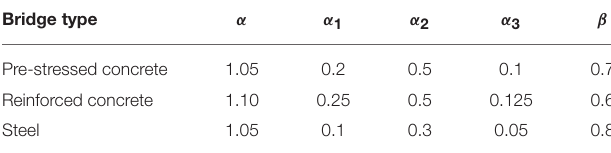
TABLE 2 | Determination of parameters per bridge type (Frýba and Pirner, 2001).